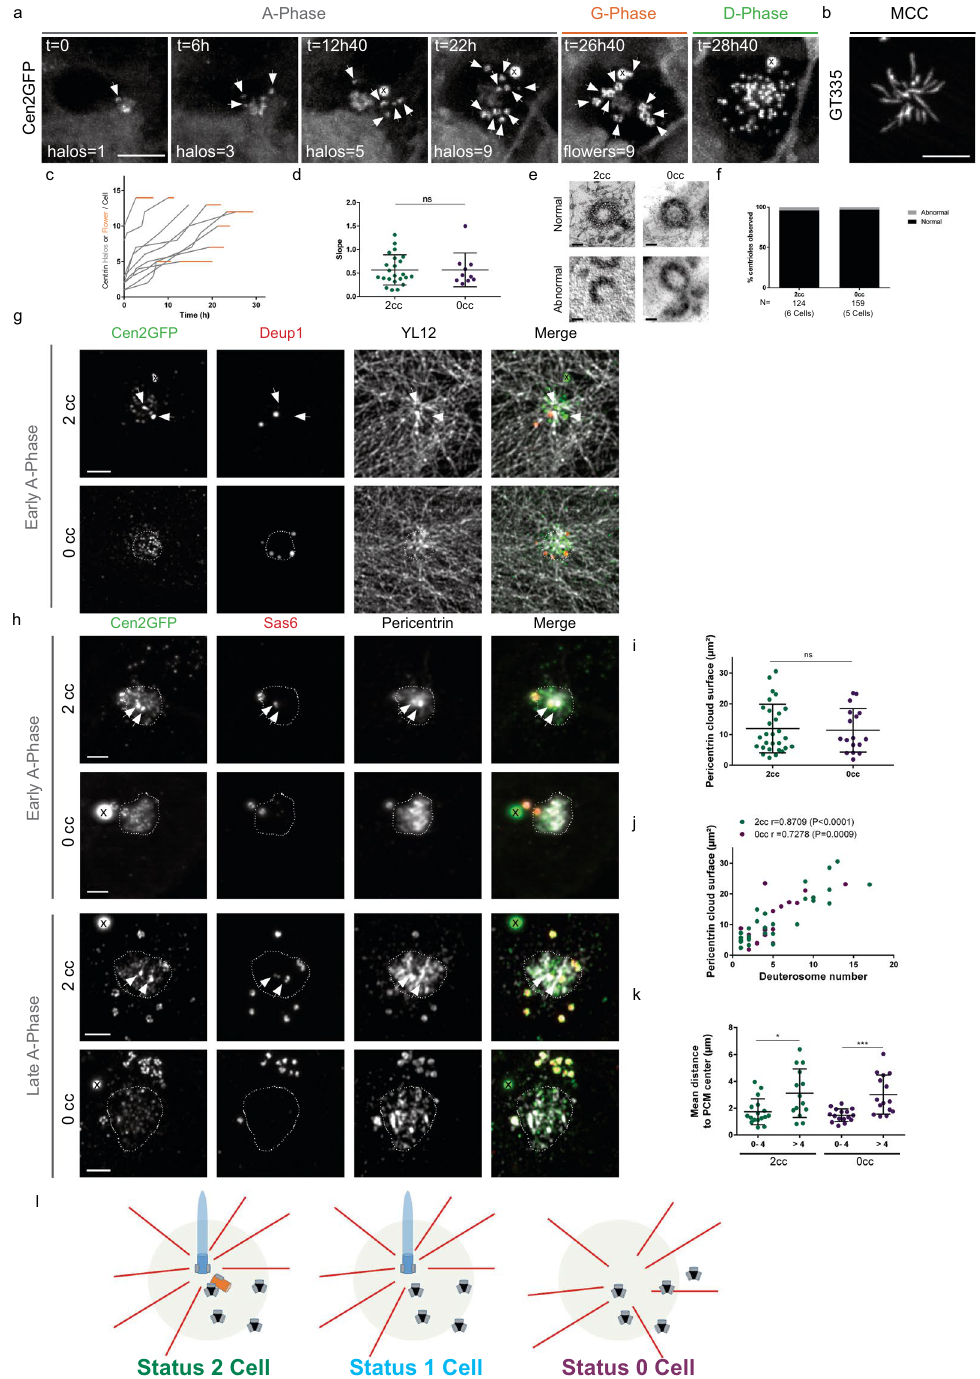
Figure 4. Centrosomal centriole-depleted cells form procentrioles within an acentriolar PCM cloud. ( a ) Live imaging of a Cen2GFP ependymal progenitor depleted from centrosomal centrioles undergoing the different stages (A-, G- and D-Phase) of centriole amplification. ( b ) GT335 immunostaining of a 0cc Cen2GFP ependymal MCC at the end of the time lapse experiment. ( c ) Number of centrin halos (Gray) or flowers (Orange) during time lapse experiments in 0cc Cen2GFP ependymal progenitors ( Δ t = 40 min, n = 10 cells). Timepoints are chosen when halos or flowers number is clearly visible. ( d ) Comparison of centrin halo formation rate between 2cc or 0cc cells during A-Phase. Each dot represents the trendline slope corresponding to a cell observed during A-Phase in Fig. 1c (2cc cells) and ( c ) (0cc cells). ( e ) Representative pictures of normal and abnormal centrioles ultrastructure in 2cc or 0cc cells observed at the multiple basal body stage. See methods. ( f ) Quantification of the integrity of centrioles ultrastructure in 2cc (6 cells observed in differentiated control cultures) and 0cc cells (5 cells observed with CLEM after videomicroscopy; See Methods). ( g ) Immunostainings showing deuterosome localization (Deup1) and the tyrosinated tubulin network (YL12)